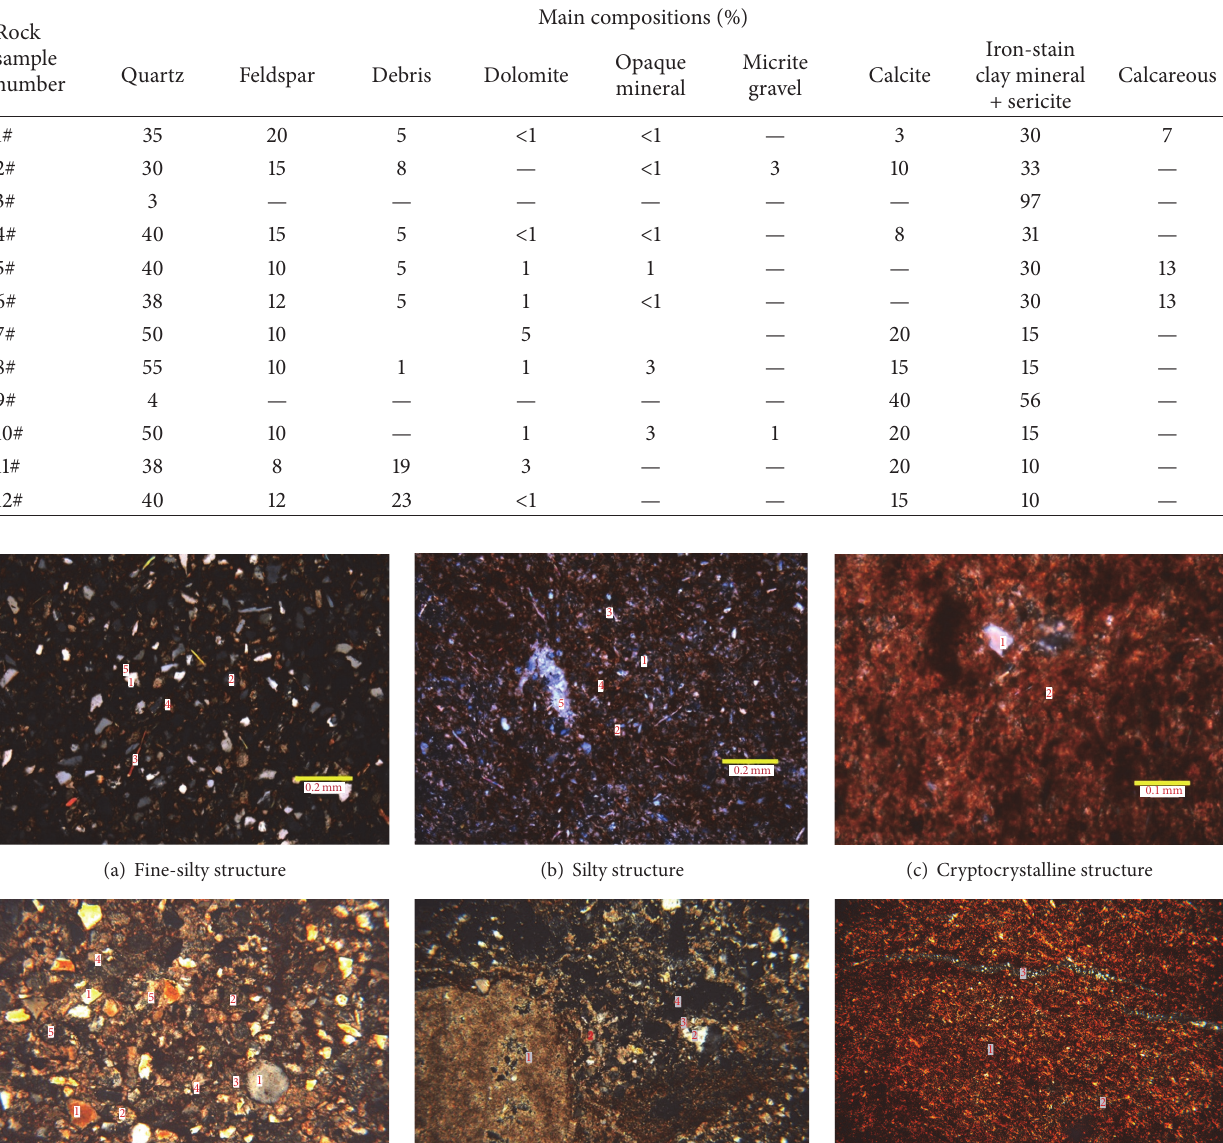
Table 1: Main mineral composition.